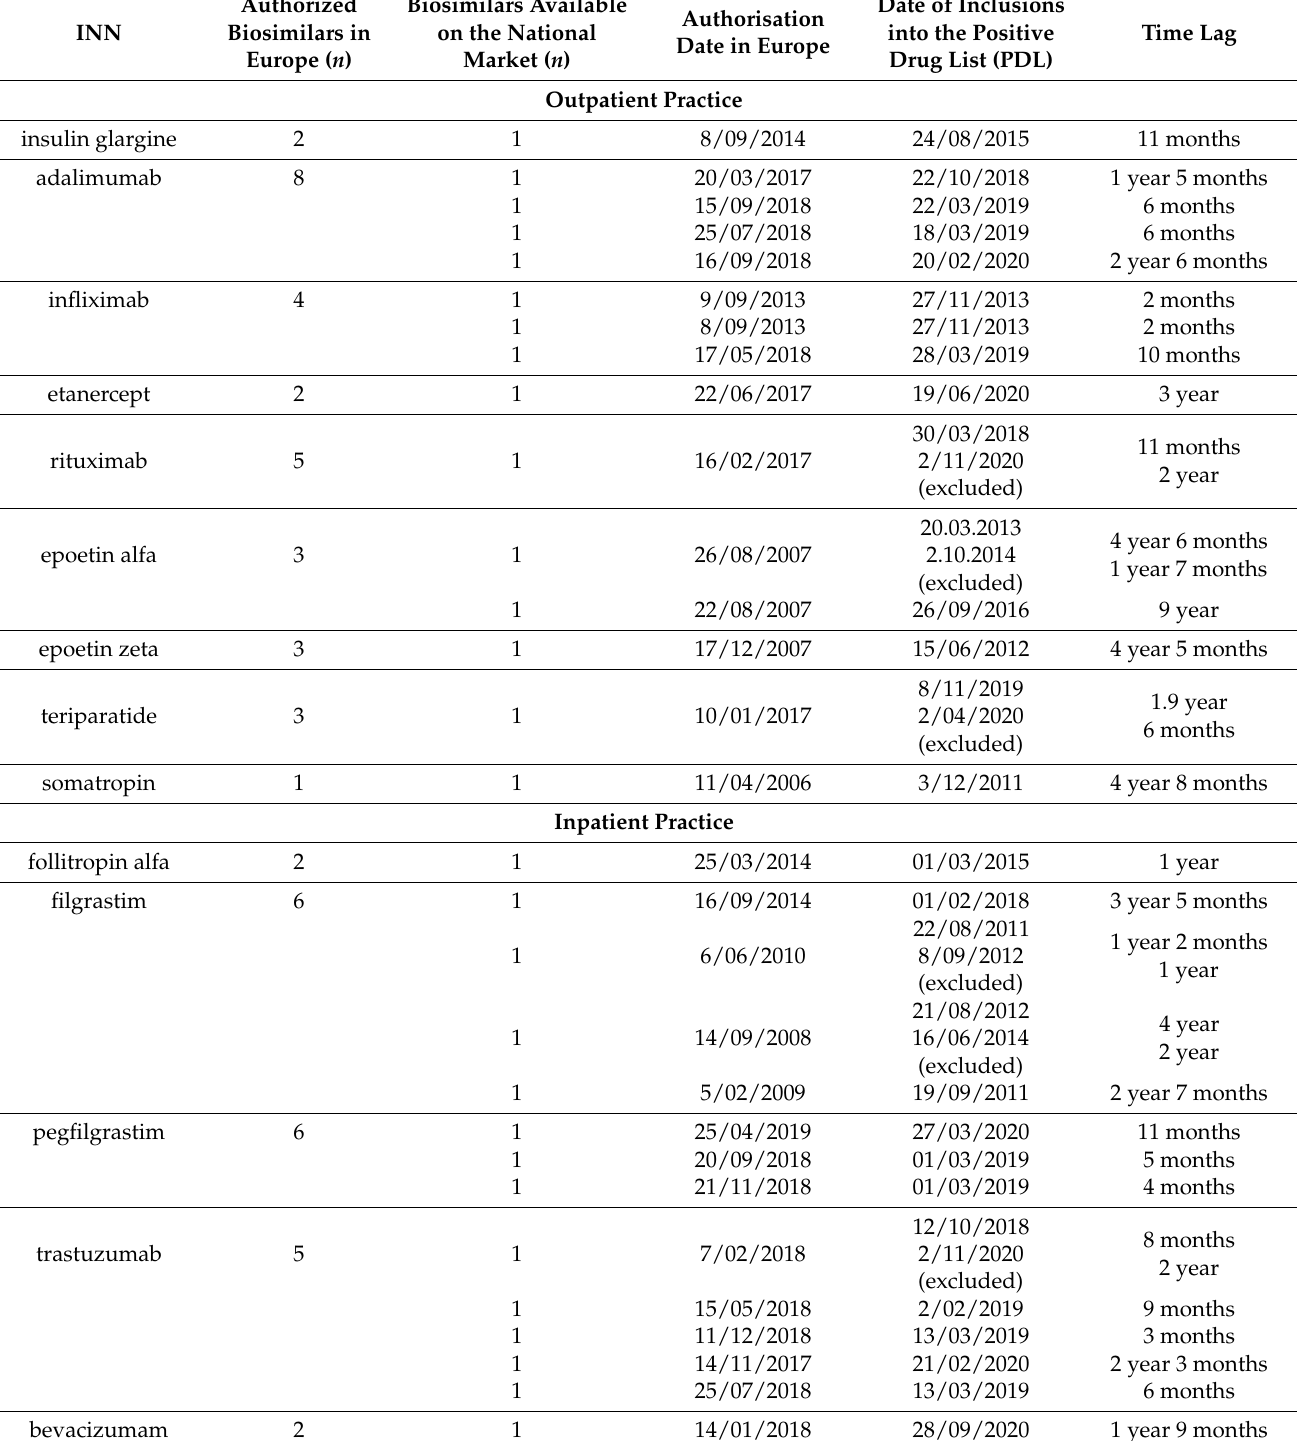
Table 1. Available biosimilar in the reimbursement practice and date of